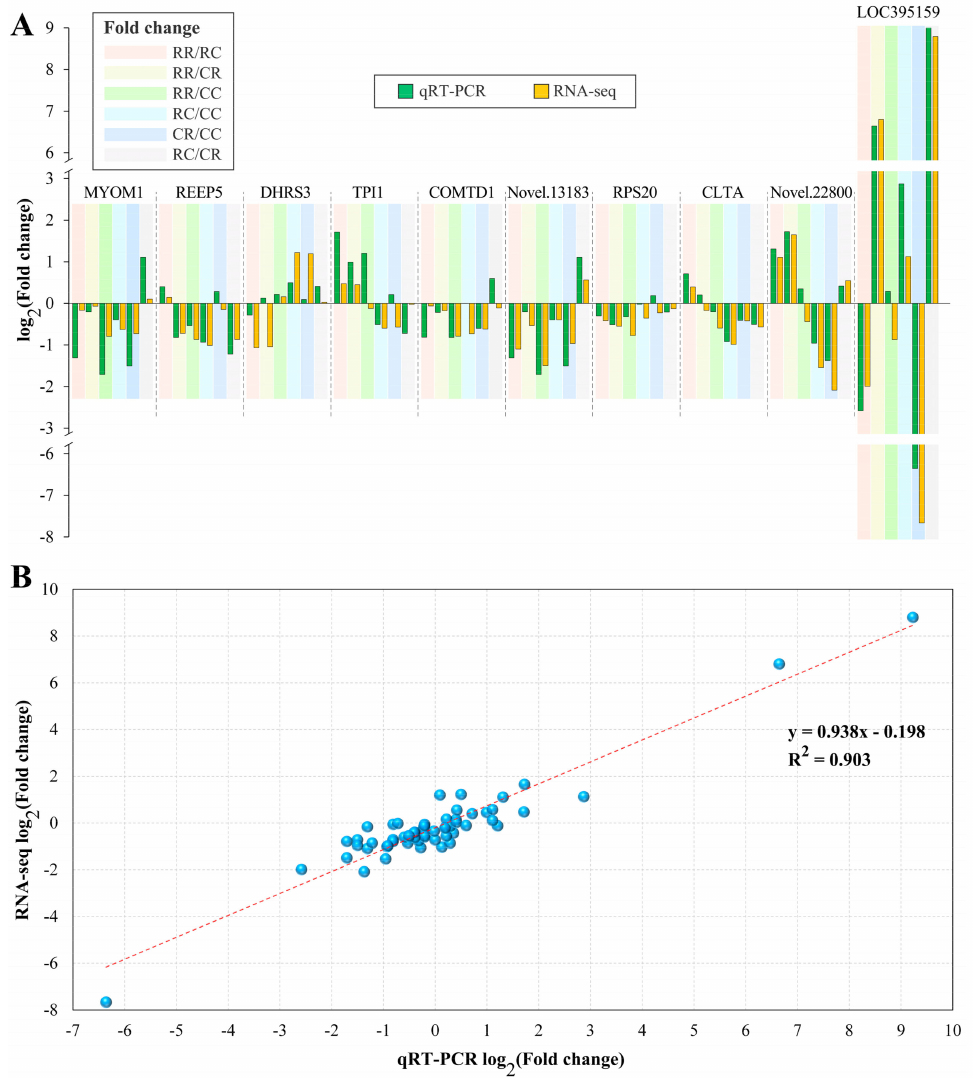
Figure 4. qRT-PCR validation of di ff erentially expressed genes (DEGs) in four groups. ( A ) Comparison of log 2 (fold change) in ten DEGs between qRT-PCR and RNA-seq, and ( B ) regression analysis of log 2 (fold change) values between qRT-PCR and RNA-seq. A high R 2 indicated that the RNA-seq data were considered to be of a high